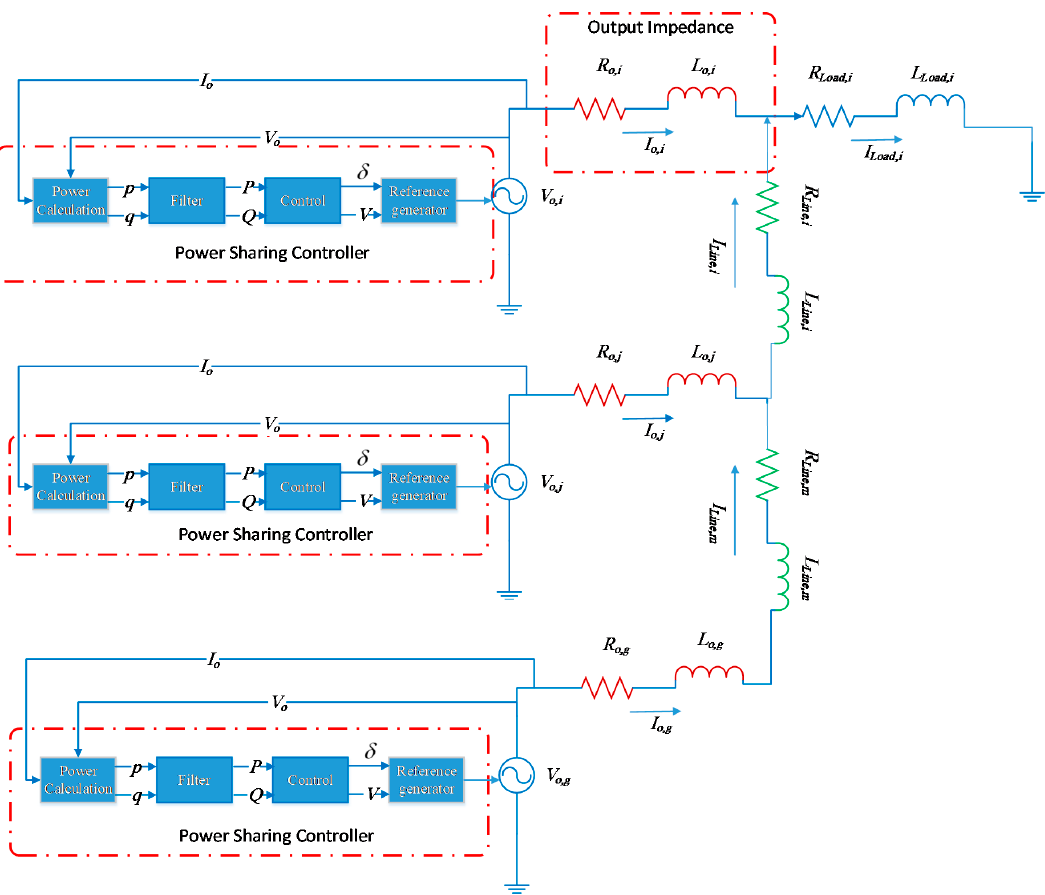
Figure 10. A multi-inverter islanded microgrid.